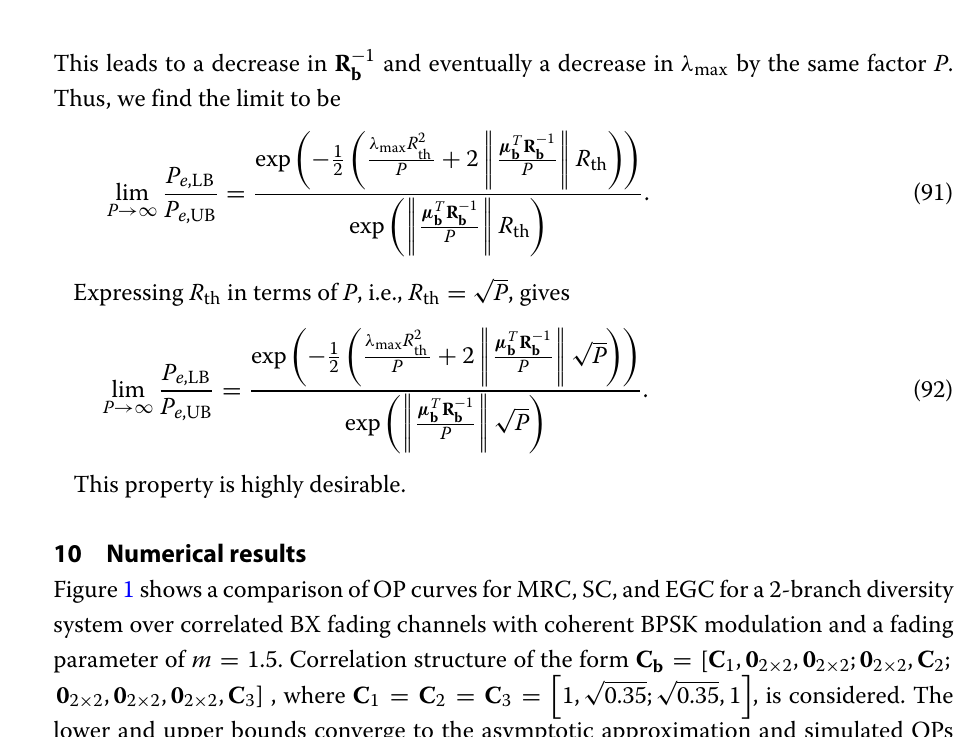
Fig. 7 BER curves for the asymptotic approximation, lower bound, and upper bound for MRC, over correlated and independent BX fading channels. The number of branches is N = 2, the fading parameter is m = 1.5, and (cid:12) C 1 , 0 2 × 2 , 0 2 × 2 ; 0 2 × 2 , C 2 , 0 2 × 2 ; 0 2 × 2 , 0 2 × 2 , C 3 the correlation structures is C b =